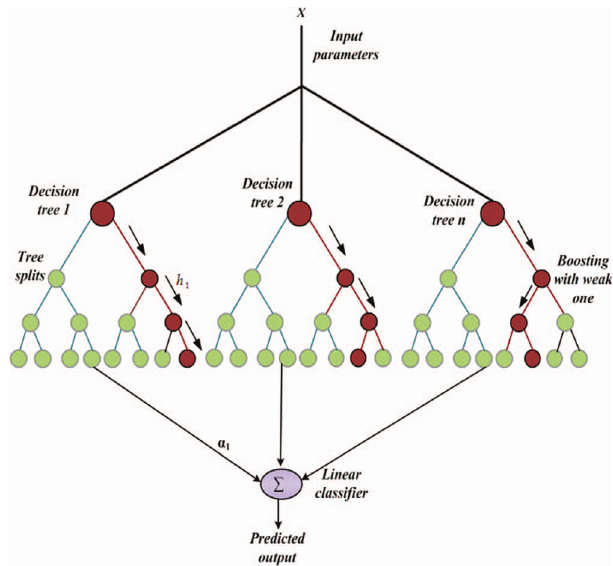
Fig. 5. Inspiration diagram of GBDT